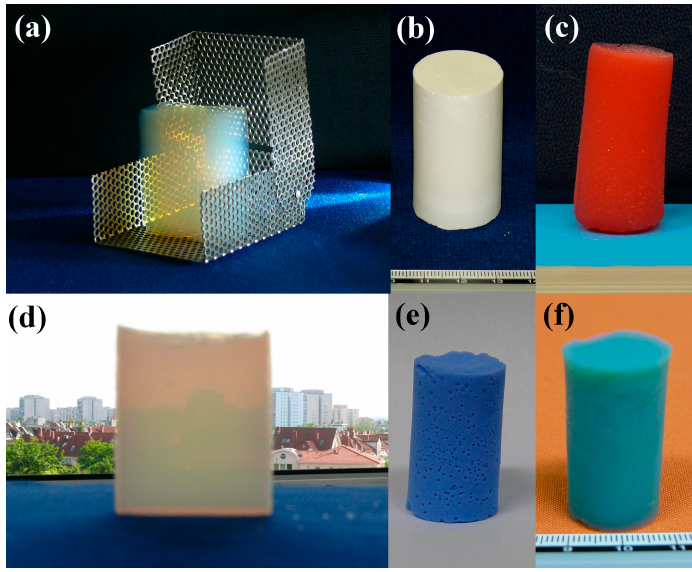
Figure 6. Representative samples of aerogels prepared by the process described in the text. ( a ) Acid-base catalyzed silica aerogel monolith placed in the drying frame for size comparison; ( b ) Silica aerogel-based artificial bone substitute material; ( c ) Fluorescent silica aerogel stained with Safranin T; ( d ) High-strength semi-transparent collagen-silica hybrid aerogel; ( e ) Silica aerogel covalently functionalized with a macrocyclic copper complex; ( f ) Chromia-silica hybrid aerogel.